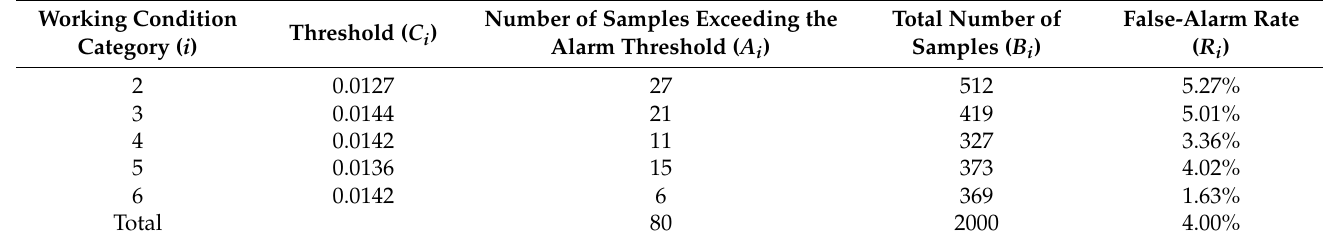
Table 5. Alarm thresholds and false-alarm rates for different working conditions.